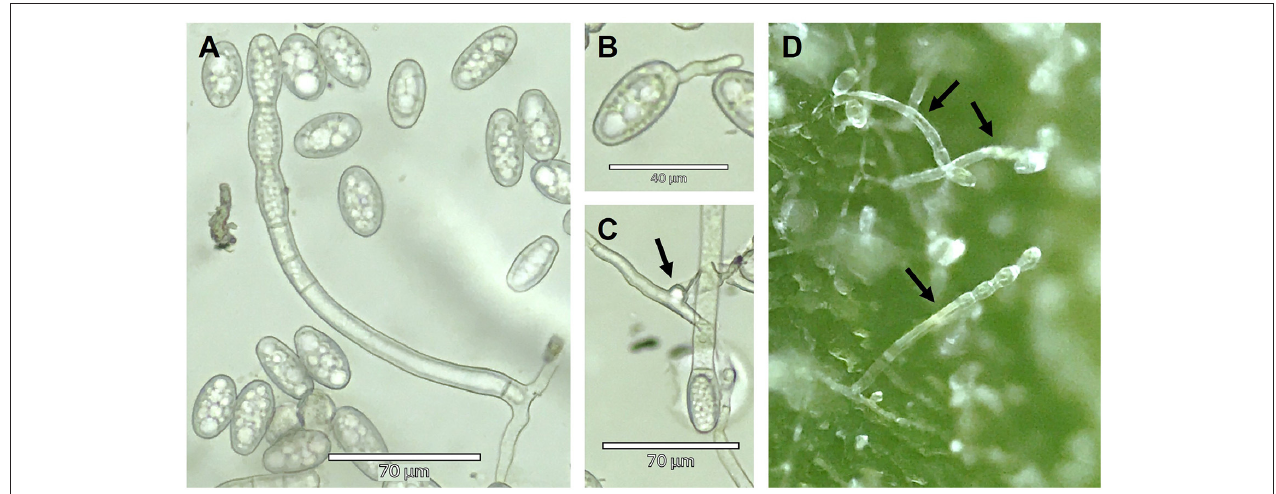
FIGURE 1 | (A) Micrograph of conidia and a conidiophore of Golovinomyces ambrosiae collected from an infected Cannabis sativa leaf, (B) a germinating conidium, (C) an appressorium (indicated by the arrow) and (D) conidiophores of G. ambrosiae (indicated by arrows) arising to produce conidia in chains from the surface of an infected C. sativa leaf.